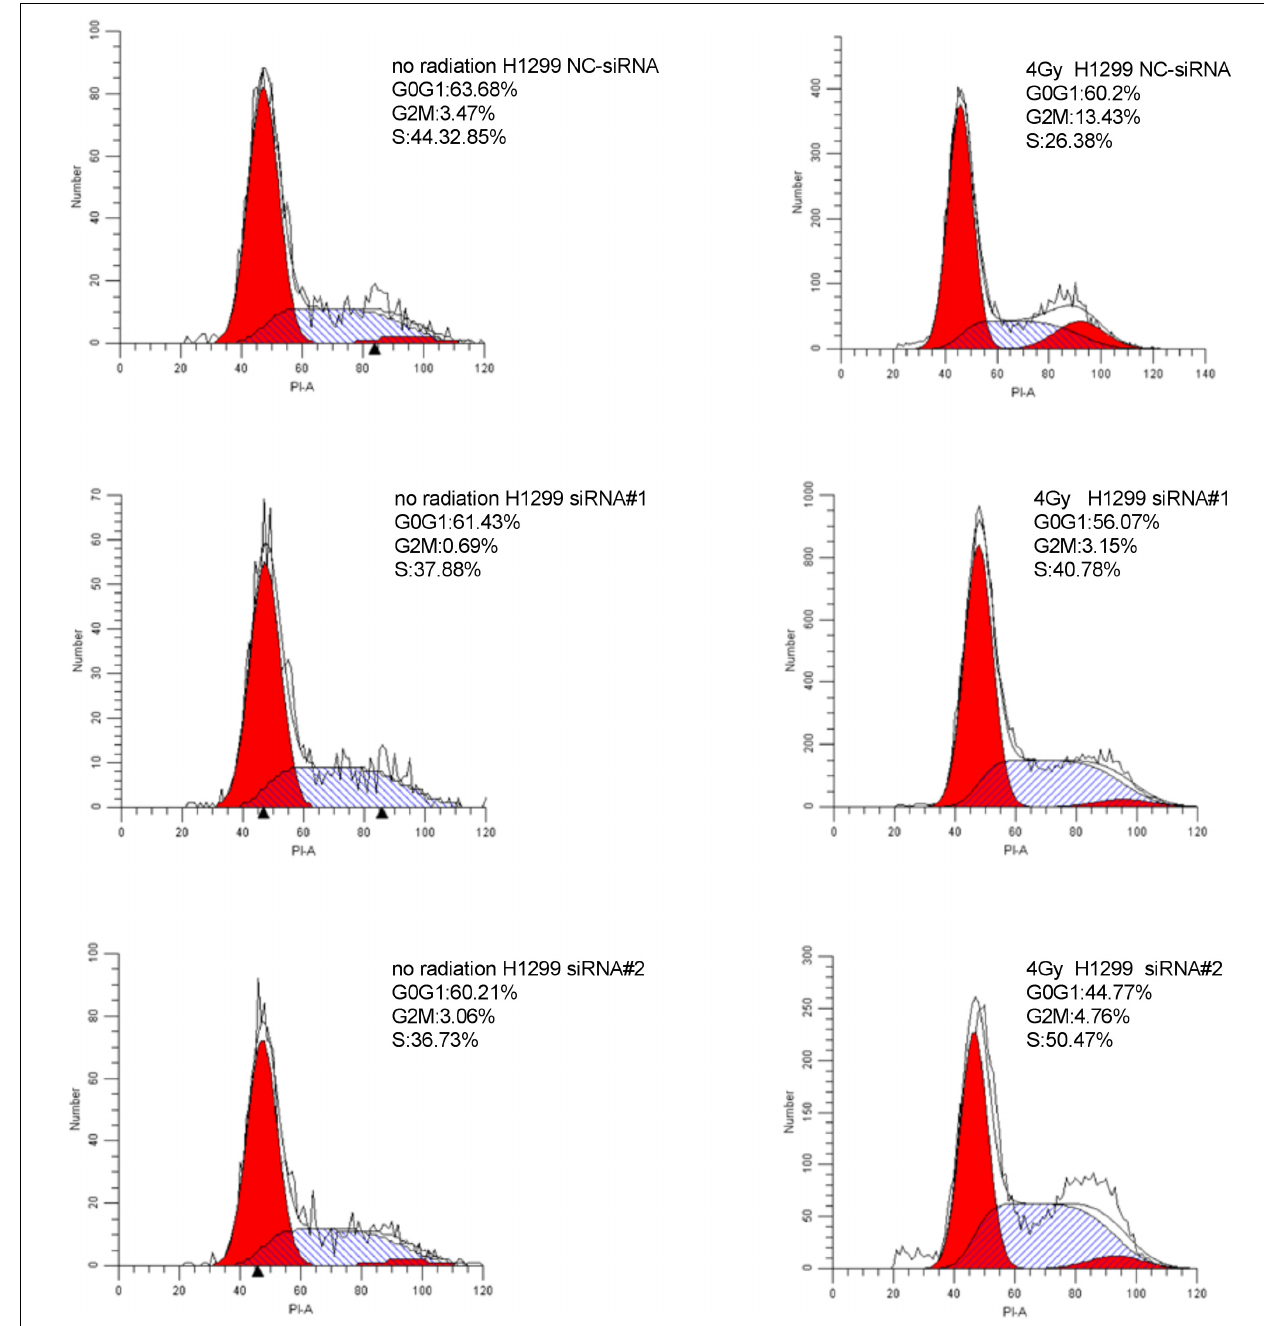
FIGURE 9 | Downregulation of PKMYT1 abolishes irradiation-induced G2/M arrest in H1299